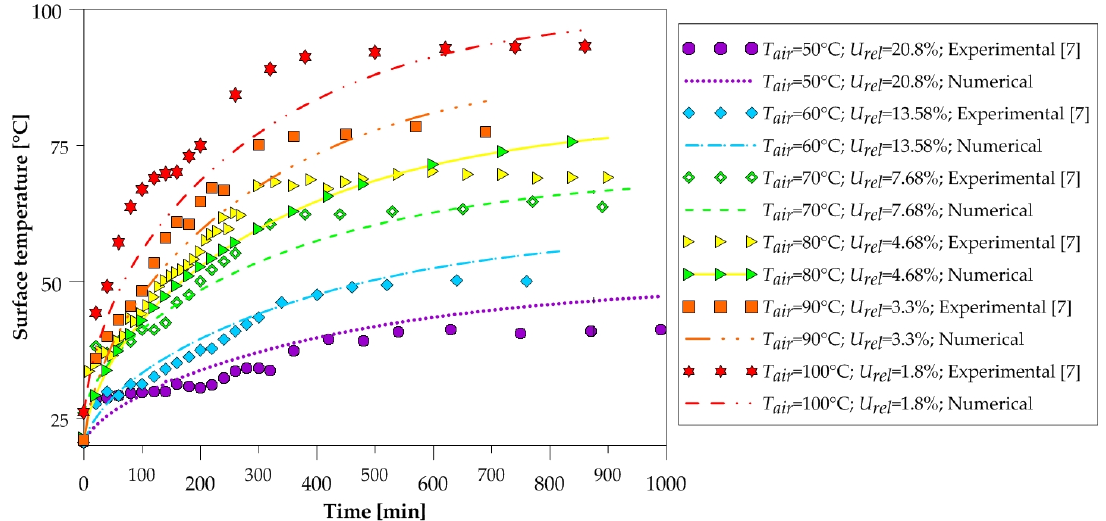
Figure 12. Mass di ff usivity in brick according to Arrhenius Law.